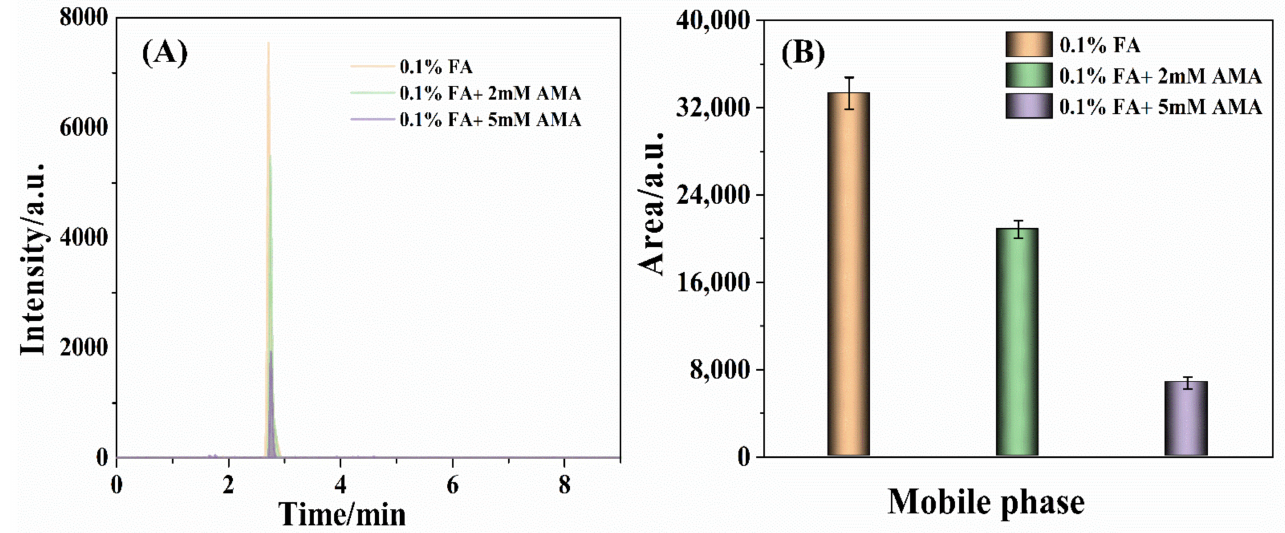
Figure 2. The chromatographic peaks ( A ) intensity and ( B ) area of the 320.2 > 302.2 m / z ion fragment detected by the BEH amide column taking 0.1% FA aqueous, 0.1% FA+ 2 mM AMA aqueous, 0.1% FA + 5 mM AMA aqueous as the mobile phase, respectively, with TTX the concentration of 25